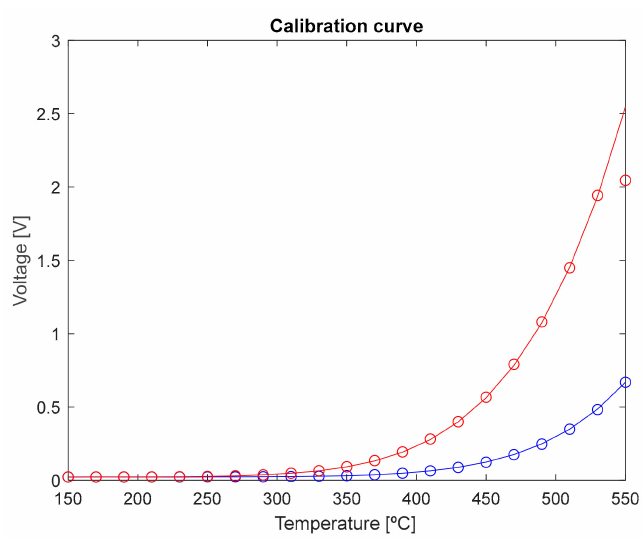
Figure 3. Experimental ( ) and fitting (-) pyrometer calibration curves at (blue line) 1.31 µ m and (cid:35) (red line) 1.55 µ m, respectively. No fiber-optic switch is included within the